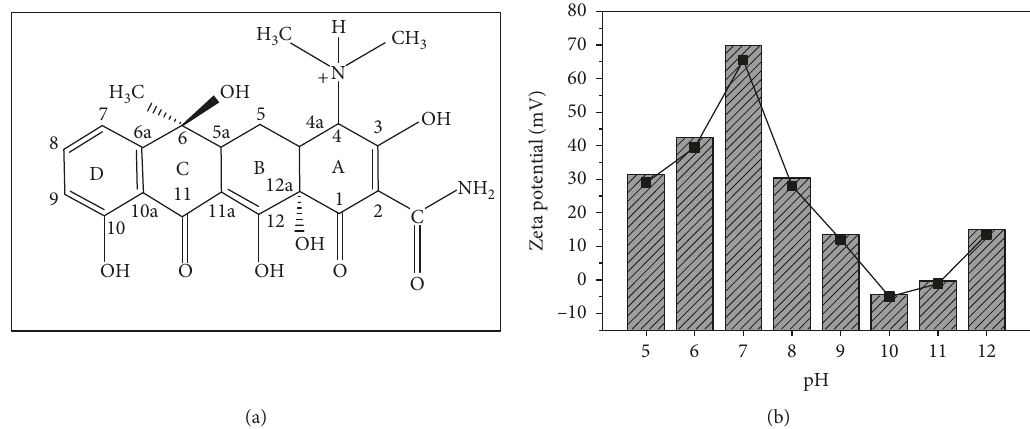
Figure 10: (a) Schematic diagram of the TC molecular structure. (b) Zeta potential distribution of ZIF-8 in aqueous solution with different pH